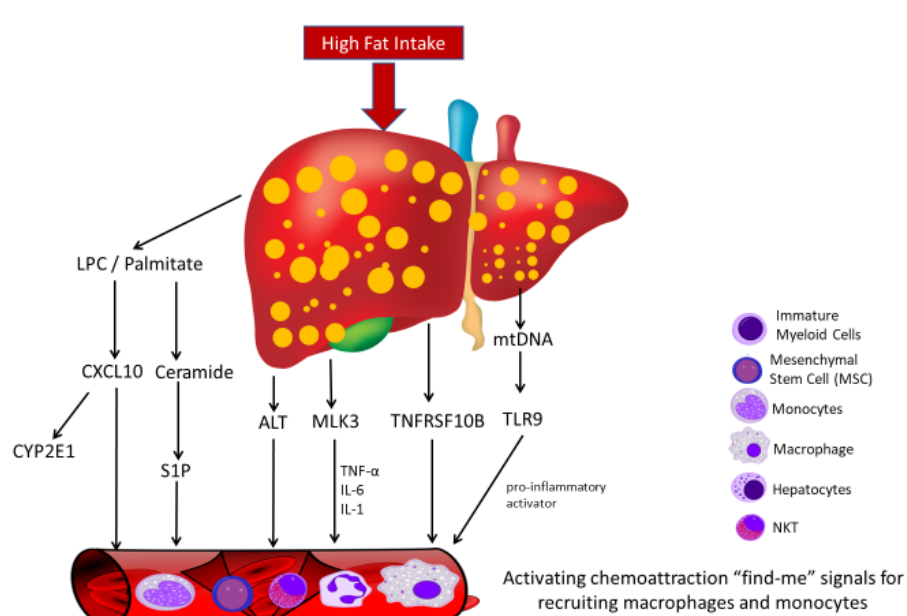
Figure Figure 2. Summary of the liquid biopsies activating chemoattraction signal pathways for recruiting immune cells in NASH/NAFLD. palmitate and lysophosphatidylcholine (LPC)-induced hepatic lipotoxicity is triggered by CXCL10 with hepatocyte-derived CYP2E1 vesicles enrichment; Palmitate- stimulated EVs are enriched in ceramide (C16:0)-derived sphingosine 1 phosphate (S1P) to chemoattract macrophages. Increased numbers of EVs derived from invariant natural killer T cells and CD14+ monocytes are associated with alanine transaminase (ALT) level in serum. Mlk3 − / − mice fed a diet that was high in fats and carbohydrates exhibited suppressed cytokine expression and macrophage infiltration compared to wild-type (WT) mice. Lipid-induced TNFRSF10B signaling causes release of inflammatory extracellular vesicles from hepatocytes. High levels of hepatocyte mtDNA in the microparticles (MPs) activated toll-like receptor 9 (TLR9) pathway for chemotaxis of neutrophils and M1 macrophages.